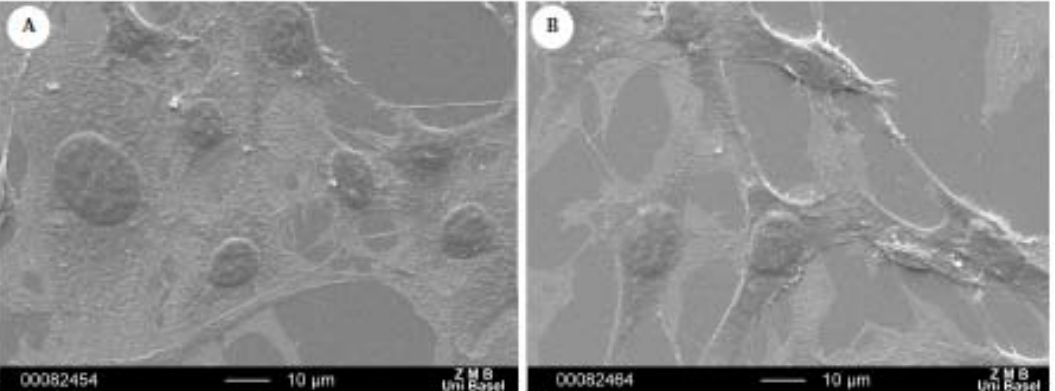
Figure 7. Effect of silver(I) compound coated-surfaces on fibroblast cells. Cell proliferation was assessed at day 3. Cells were fixed onto surfaces, dehydrated, thinly sputted with gold and examined using a Scanning Electron Microscope. ( A ): gold Au(111) uncoated; ( B ) gold Au(111) coated with compound 2